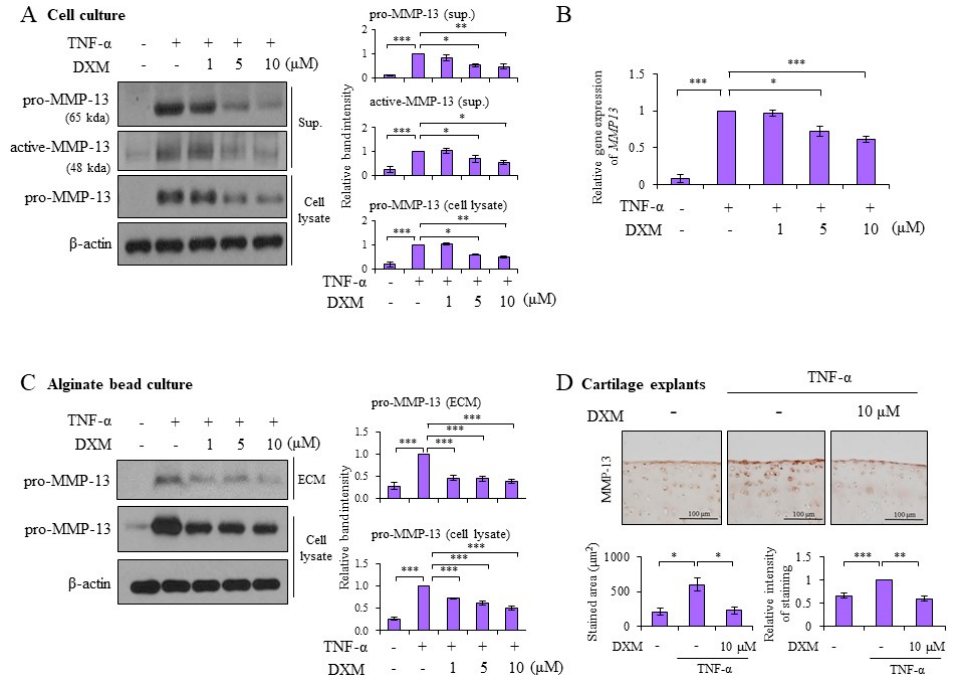
Figure 2. DXM repressed TNF- α -induced matrix metalloproteinases (MMP)-13. ( A ) Porcine chondrocytes were treated with TNF- α (5 ng/mL) and various doses of DXM as indicated for 24 h. Total cell lysate and supernatants (Sup.) were collected for analysis of pro-MMP-13 and active-MMP-13 expression by Western blotting. ( B ) Porcine chondrocytes were treated with TNF- α (5 ng/mL) and various doses of DXM for 8 h. Cellular mRNA were analyzed by real-time RT-PCR. ( C ) Porcine chondrocytes cultured in alginate beads were treated with TNF- α (5 ng/mL) in the presence of various doses of DXM for 72 h. MMP-13 levels were evaluated in cell lysate and extracellular matrix (ECM) with Western blots. ( D ) Cartilage explants were treated with TNF- α (5 ng/mL) in the presence or absence of DXM (10 µ M) for 7 days. Expression of MMP-13 in cartilage explants was analyzed by immunostaining (original magnification × 100) and the staining intensity and stained areas were calculated. Data are shown as representative data from at least three independent experiments of different donors. Values are the means ± S.E.M. and significance (* p < 0.05; ** p < 0.01; *** p < 0.001) was analyzed by one-way ANOVA or Student’s t -test. The symbol of plus (+) or minus ( − ) indicates presence or absence of treatment, respectively.